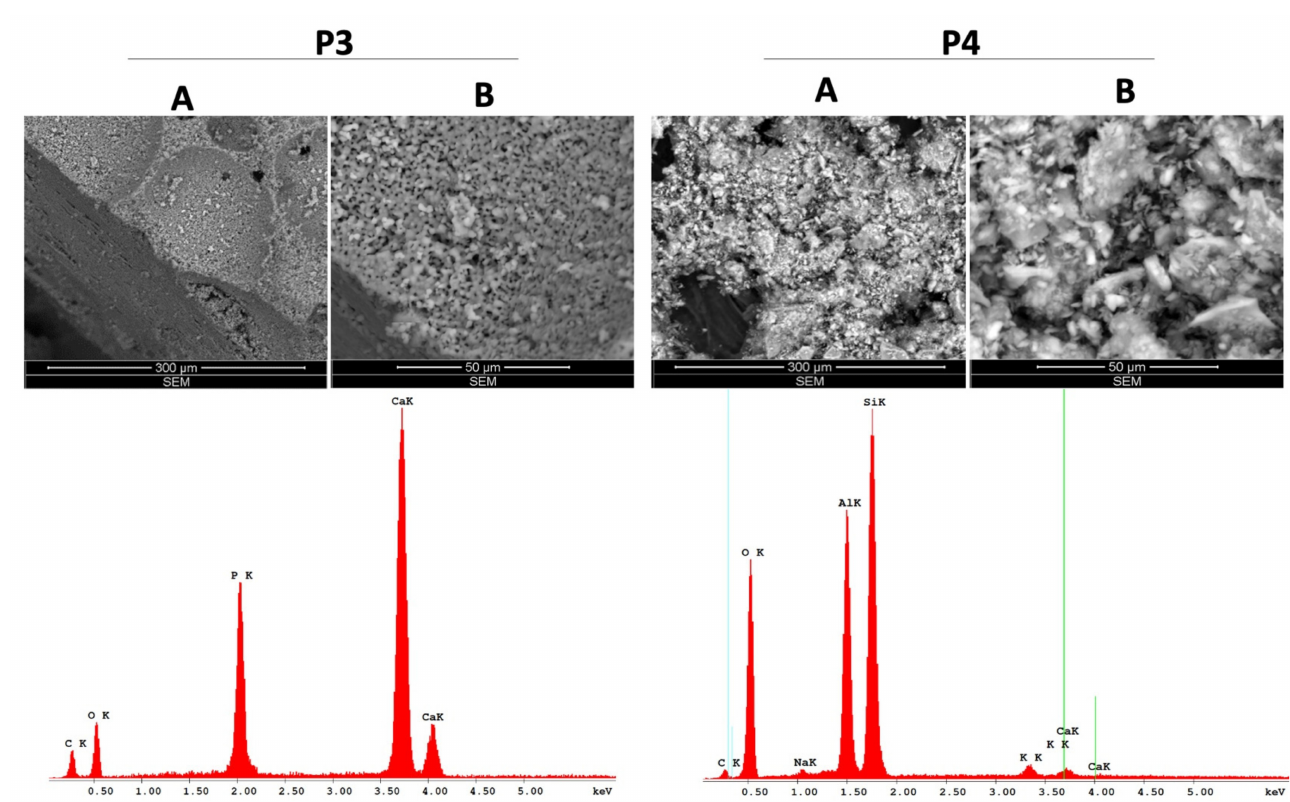
Figure 3. SEM–EDAX analysis of the scaffold-type ceramics (P3, P4); A —represents the general aspects of the samples and B —represents the ultrastructure details of the samples.